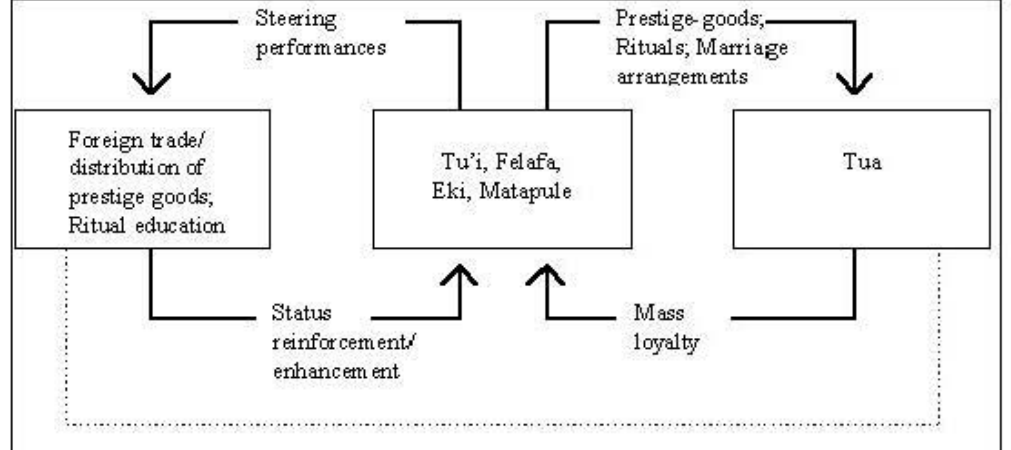
figure J. Revised conception of socio-political organization applied to Tonga. At the center offigurc J arc the Tongan elites, the Tt~is and the other nobility. Through them prestige-goods, rituals, and ad .. <ll!tageous marriage arrangements (which arc, as [Page